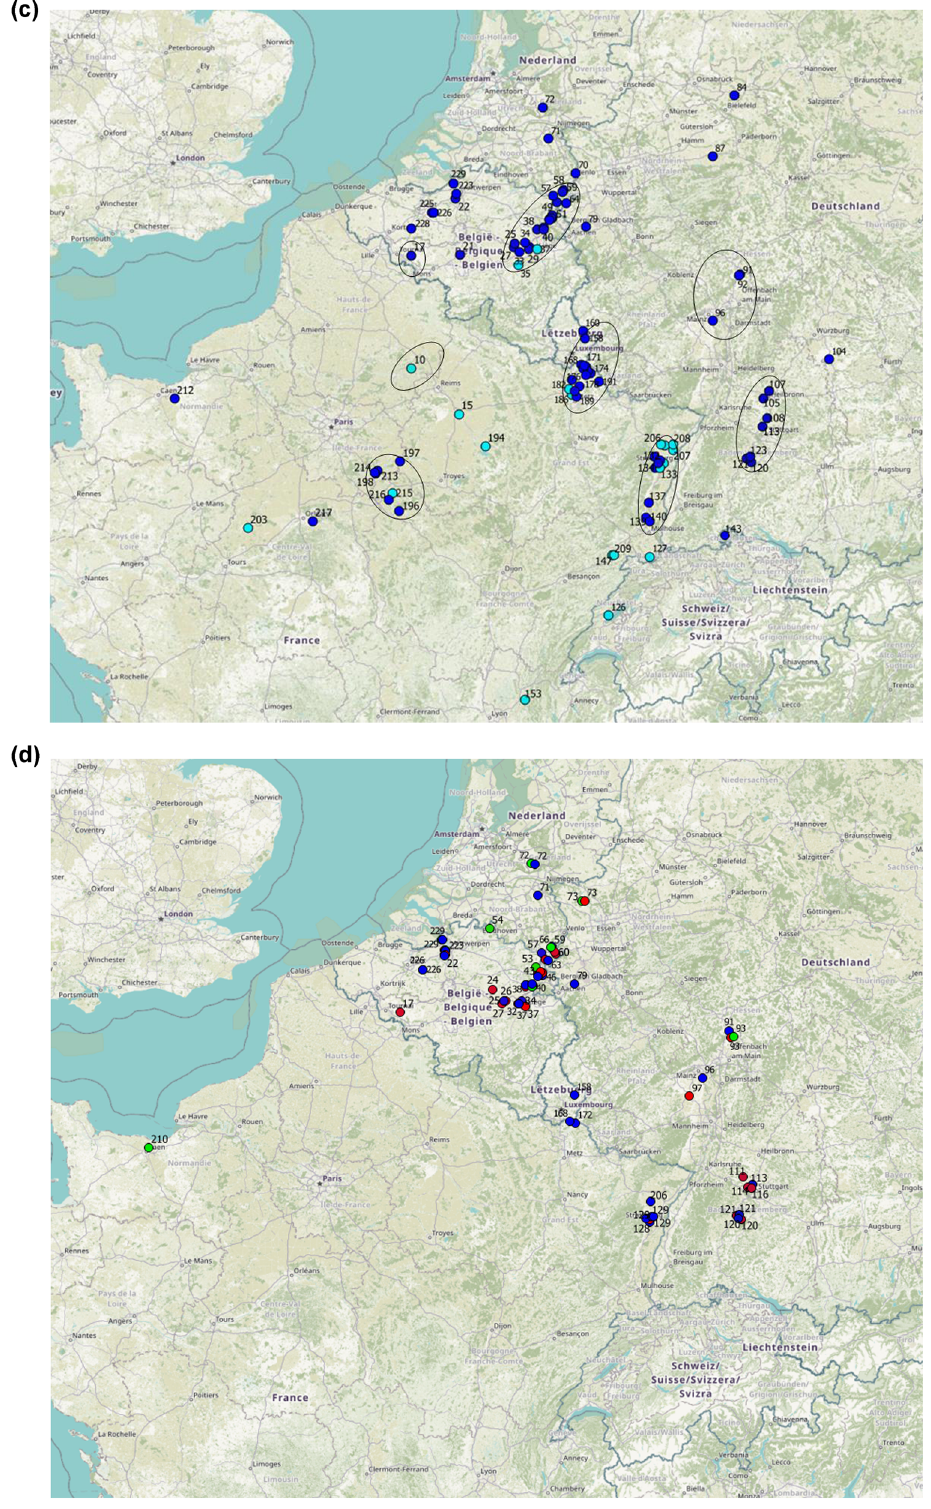
Figure 1: Distribution maps of bone - tempered ( a ) ( red ) , organic - tempered ( b ) ( green ) , and mineral - tempered ( c ) ( blue ) Non - LBK pottery. The light blue circles in ( c ) denote fossil shell - tempered Non - LBK pottery. The circles denote LBK settlement clusters. The distribution of grog - tempered Non - LBK pottery is shown in ( d )